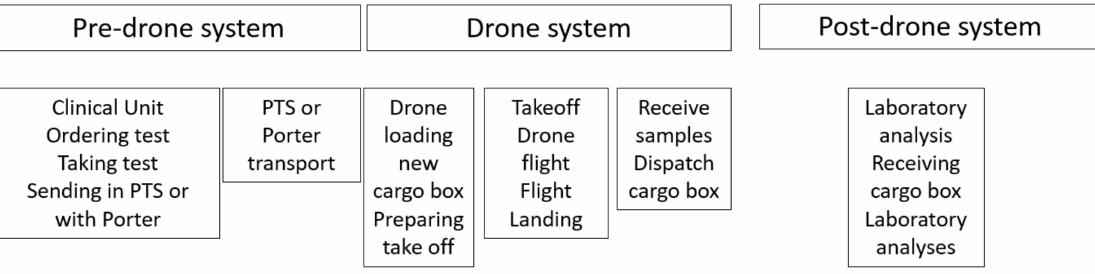
Figure 3. Structure of the analytical approach: pre-drone system including the clinical activity, drone system for transport from the clinic to the laboratory and post-drone system including laboratory analysis. (PTS = pneumatic transport